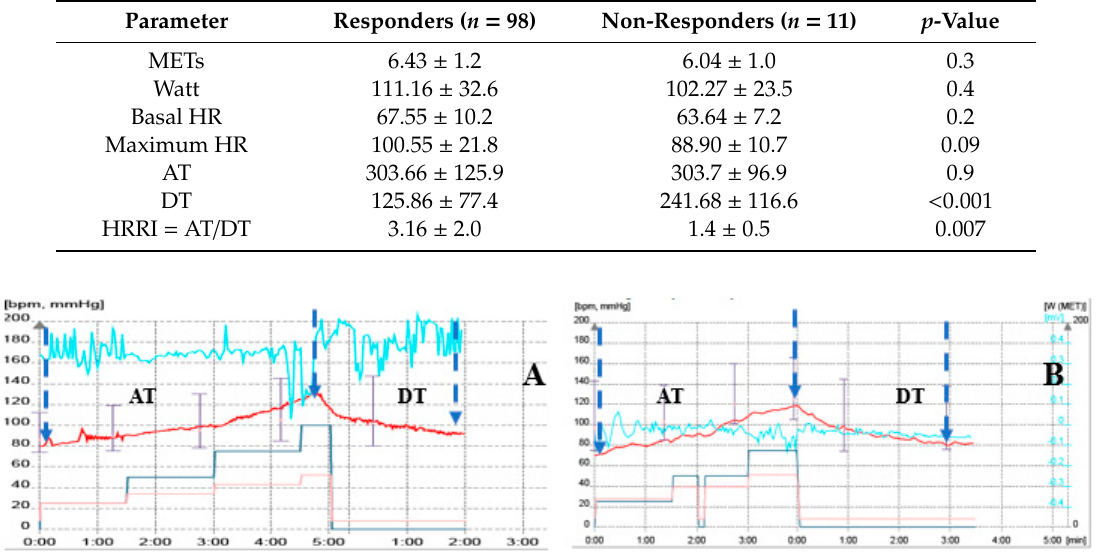
Figure 2. Example of HR diagram (red line) in a responder (A) and non-responder (B). HRRI is obviously better in patient A (HRRI = 2.5) versus patient B (HRRI = 1.33). AT = acceleration time; DT = deceleration time.